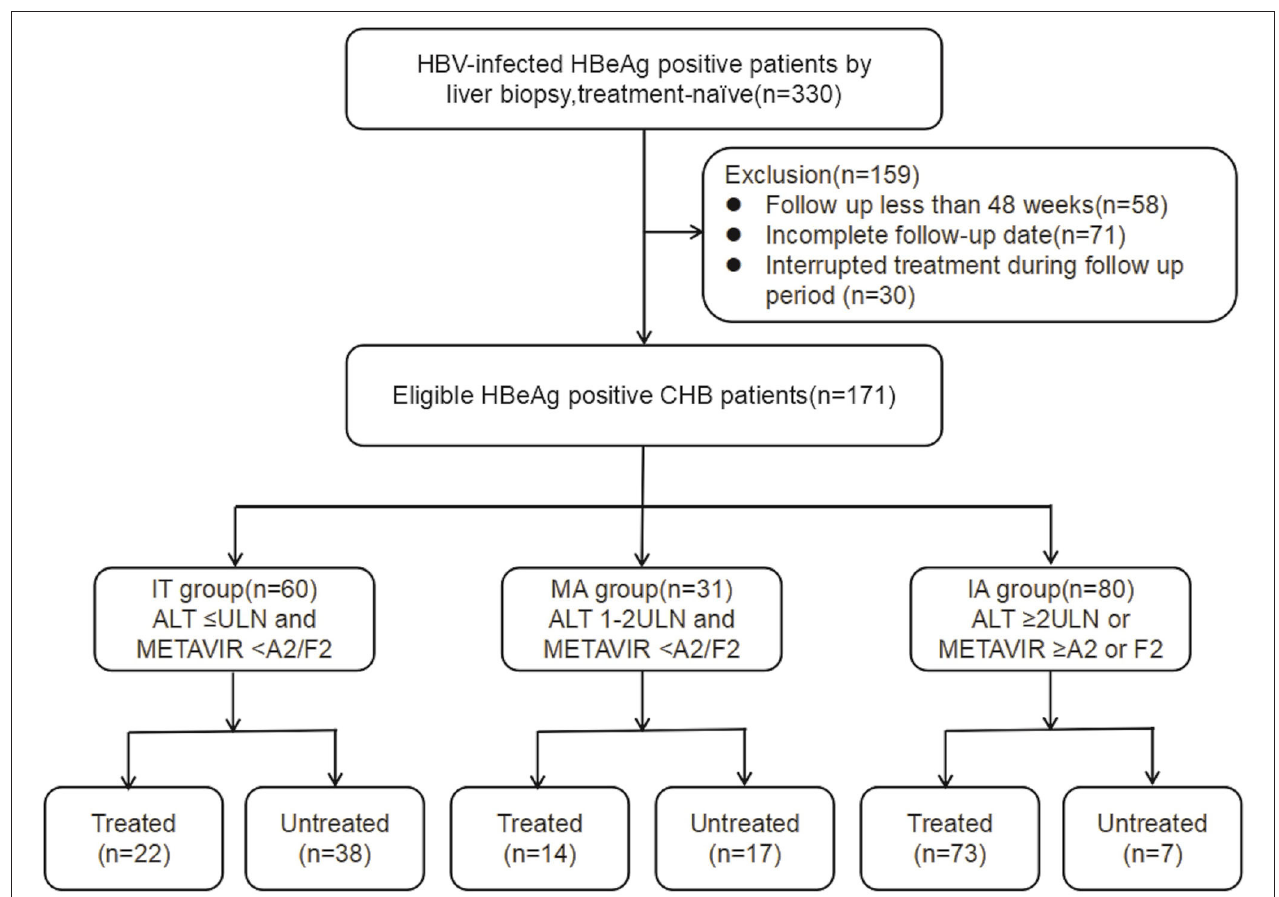
FIGURE 1 | Flowchart showing enrollment of study patients. IT, immune tolerant; MA, mildly active; IA, immune active; CHB, chronic hepatitis; AST, aspartate aminotransferase; ULN, upper limit of normal.